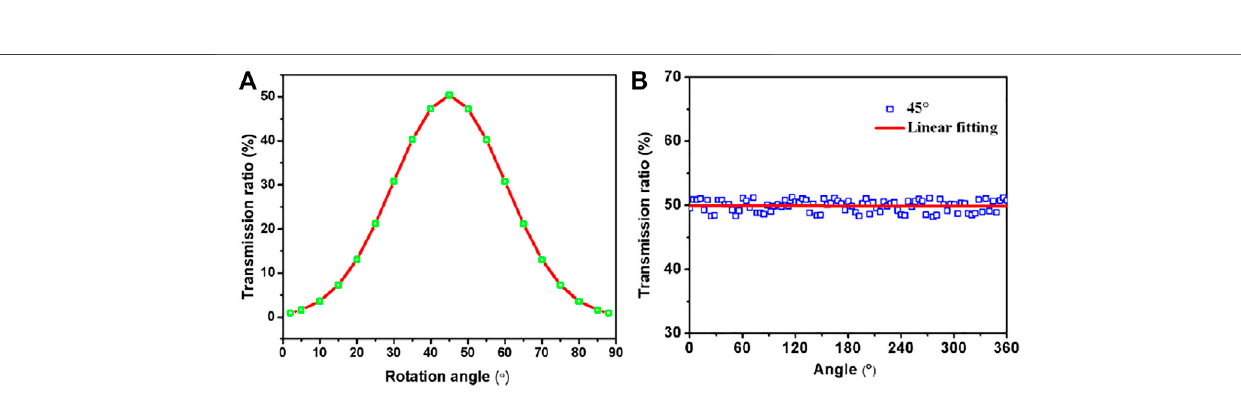
FIGURE 12 | (A) Variation of transmission ratio with the rotation angle of HSFL, (B) with the rotation angle of the analyzer GP 2 . The hole squares are experimental results, and the solid red curve is the theoretical value of a quarter-wave plate.